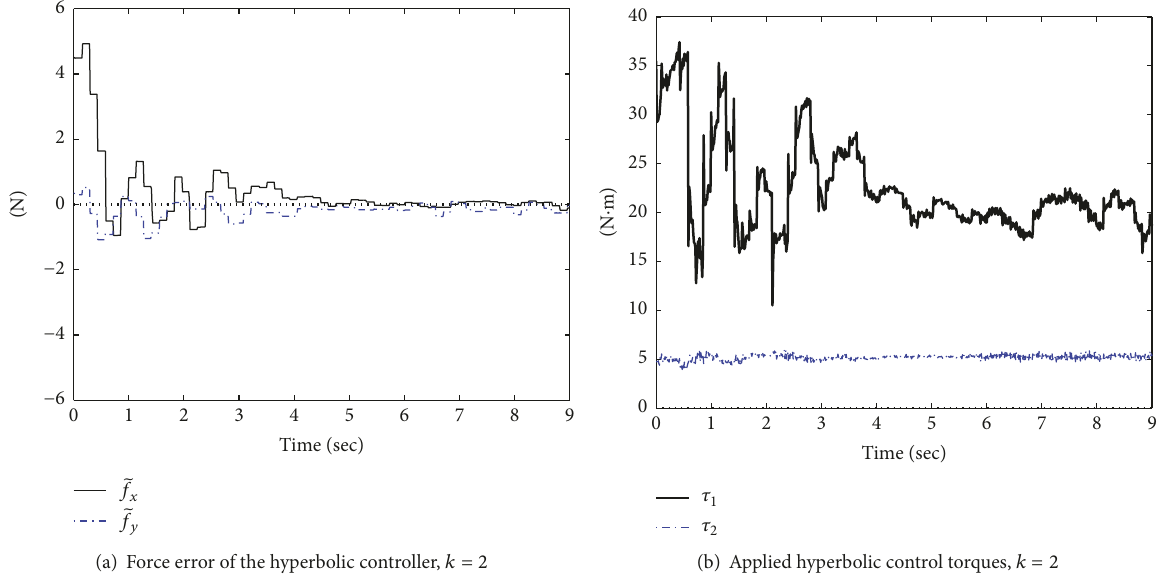
Figure 6: Experimental results for the hyperbolic control 𝜏 2 = J ( q ) 𝑇 f 𝜒2 with 𝑘 = 2